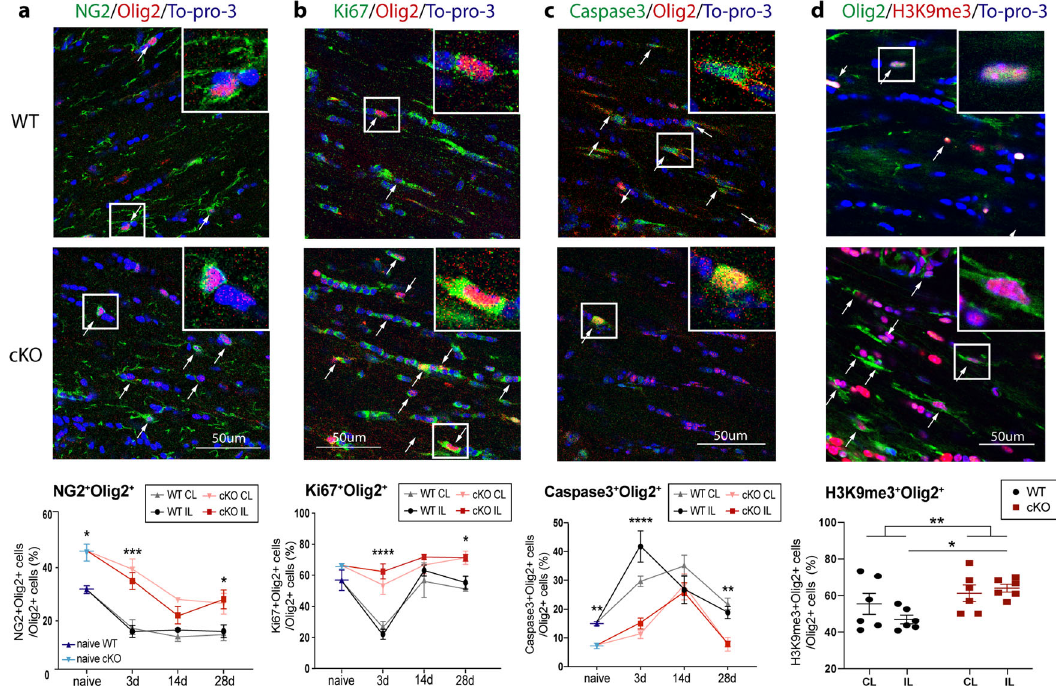
Fig. 7 Increased oligodendrogenesis contributed to enhanced myelination in the microglial Nhe1 cKO mice. a – c Representative images and quantitative analysis of NG2 + /Olig2 + , Ki67 + /Olig2 + , and Caspase3 + /Olig2 + cells in CL and IL hemispheres of CC. d Changes of OPC differentiation marker H3K9me3 expression in CC at 3 d post-stroke. N = 3 animals for naïve (non-stroke) mice; N = 6 – 7 animals for 3d post-stroke; N = 3 – 4 for 14d post-stroke; N = 3 – 4 for 28d post-stroke. Data are mean ± SEM. * p < 0.05, ** p < 0.01, *** p < 0.001, **** p <